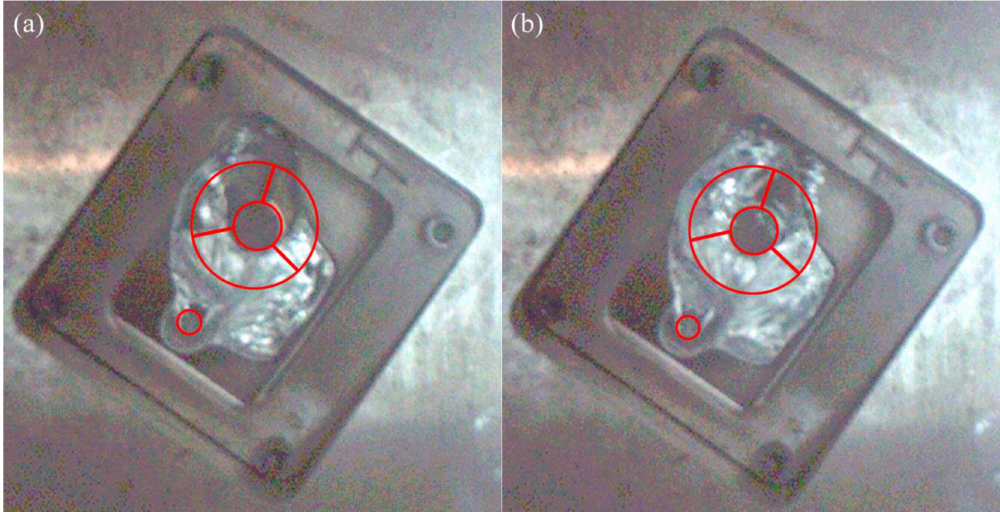
Figure 13. Flow pattern under the fast shot velocity of 1.59 m/s in the right window. ( a , b ) are arranged according to the order of